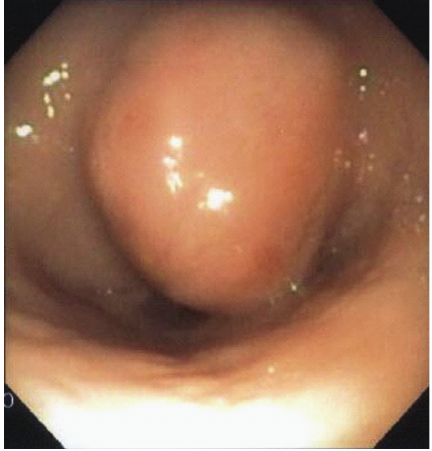
Figure 2: Subepithelial round mass in the antrum measuring from 1.5 to 2cm, resembling gastrointestinal stromal tumor.